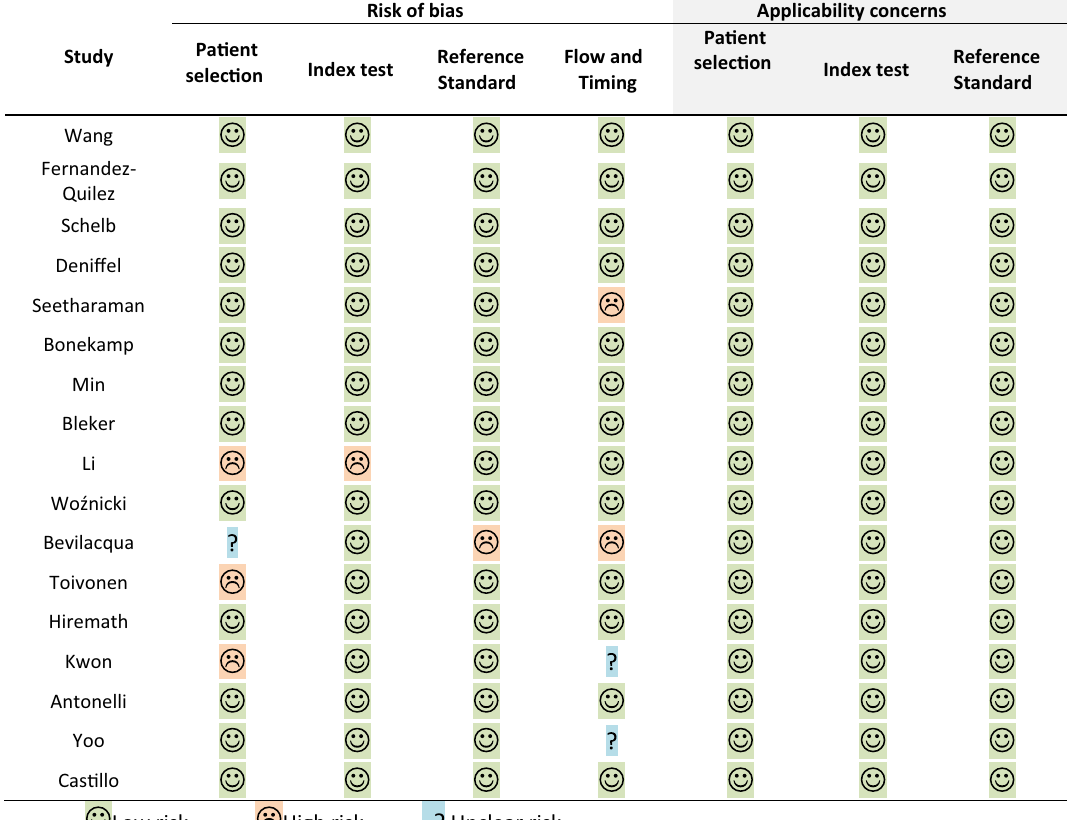
Table 1 QUADAS-2 risk of bias and applicability concerns